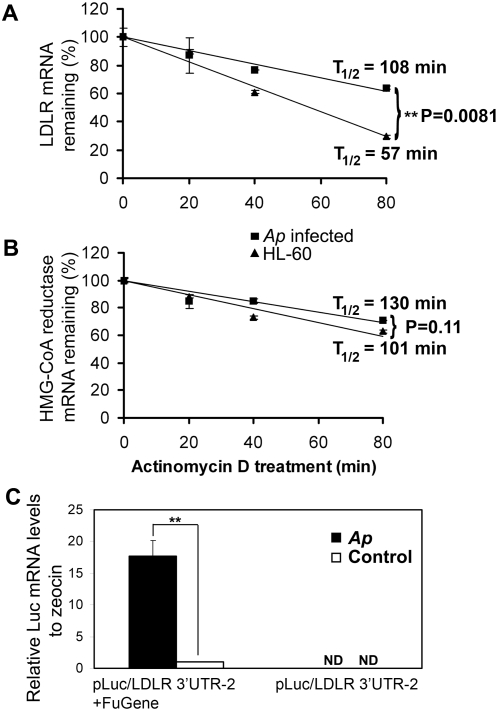
LDLR mRNA is stabilized in A. phagocytophilum–infected host cells.Actinomycin D (5 µg/ml) was added to uninfected and A. phagocytophilum–infected HL-60 cells for different periods. Total RNA was isolated, and LDLR mRNA (A) and HMG-CoA reductase mRNA (B) were analyzed by quantitative RT-PCR. Data are expressed as mean±standard deviation (n = 3) and are representative of two independent experiments. The decay rates of LDLR mRNA (A) are significantly different (p<0.01), as tested by two-way ANOVA. (C) Chimeric pLuc/LDLR 3′UTR-2 was transfected into RF/6A cells using FuGene HD reagent, and host cell–free A. phagocytophilum was added to transfected RF/6A cells at 1 day post transfection. Luc mRNA was analyzed on day 2 p.i. by quantitative RT-PCR. Cell samples were normalized by the antibiotic gene zeocin mRNA level. Data are representative of two independent experiments. Ap, A. phagocytophilum. ND, not detectable. **, p<0.01 (unpaired two-tailed t-test).